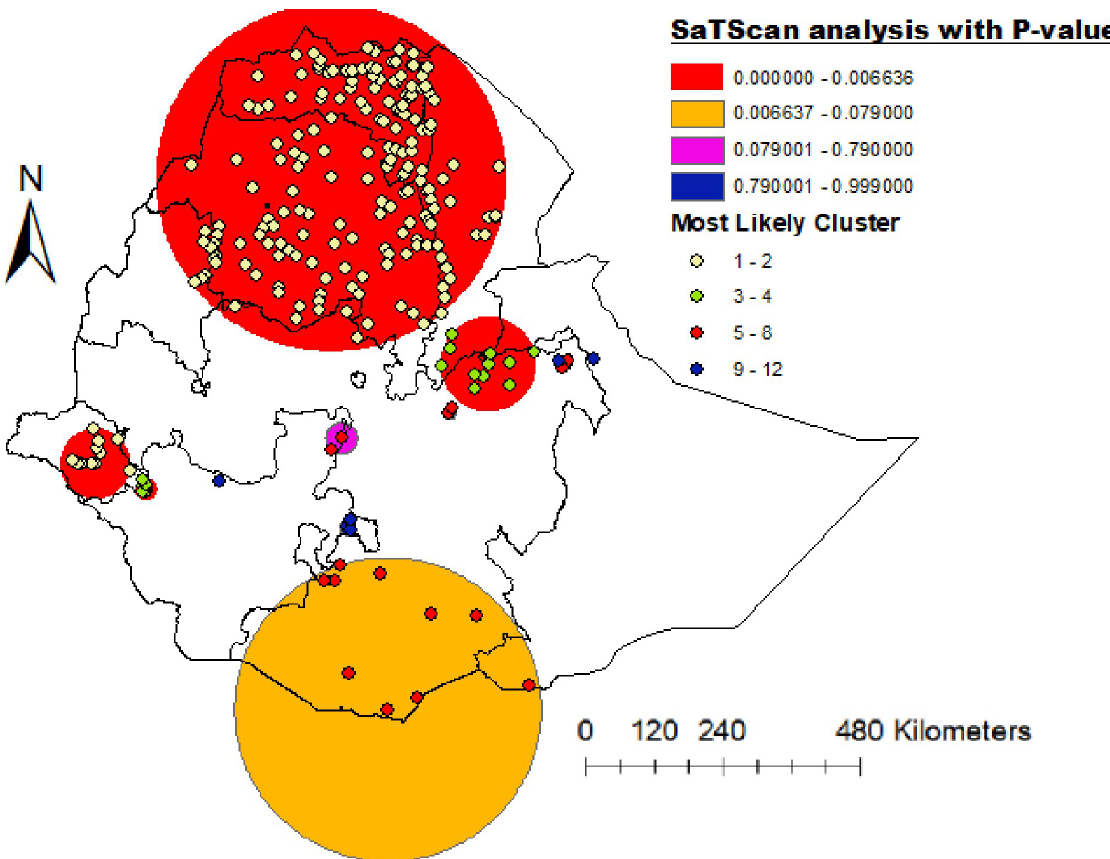
Fig 4. SaTScanAnalysisof unemployment women in Ethiopia, 2016 EDHS (Source of shapefiles: https://africaopendata.org/dataset/ ethiopia-shapefiles).